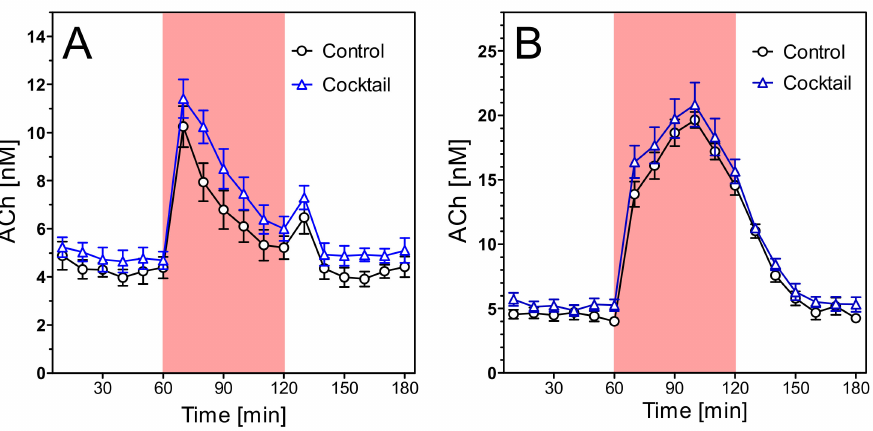
Figure 11. Extracellular ACh concentrations in hippocampus of 15–16 months old wild-type rats during open field test ( A ) and during scopolamine perfusion ( B ). The rats were submitted to two different treatments: no treatment (“control”) and cocktail. The red area represents the intervention (open field exposure) from 60–120 min. Data are means ± SEM ( n = 9–10) and were analysed by two-way ANOVA for treatment as variable followed by Bonferroni’s multiple comparison test: ( A ) F1,289 = 2.24, p = 0.15. ( B ) F1,289 = 1.93, p =